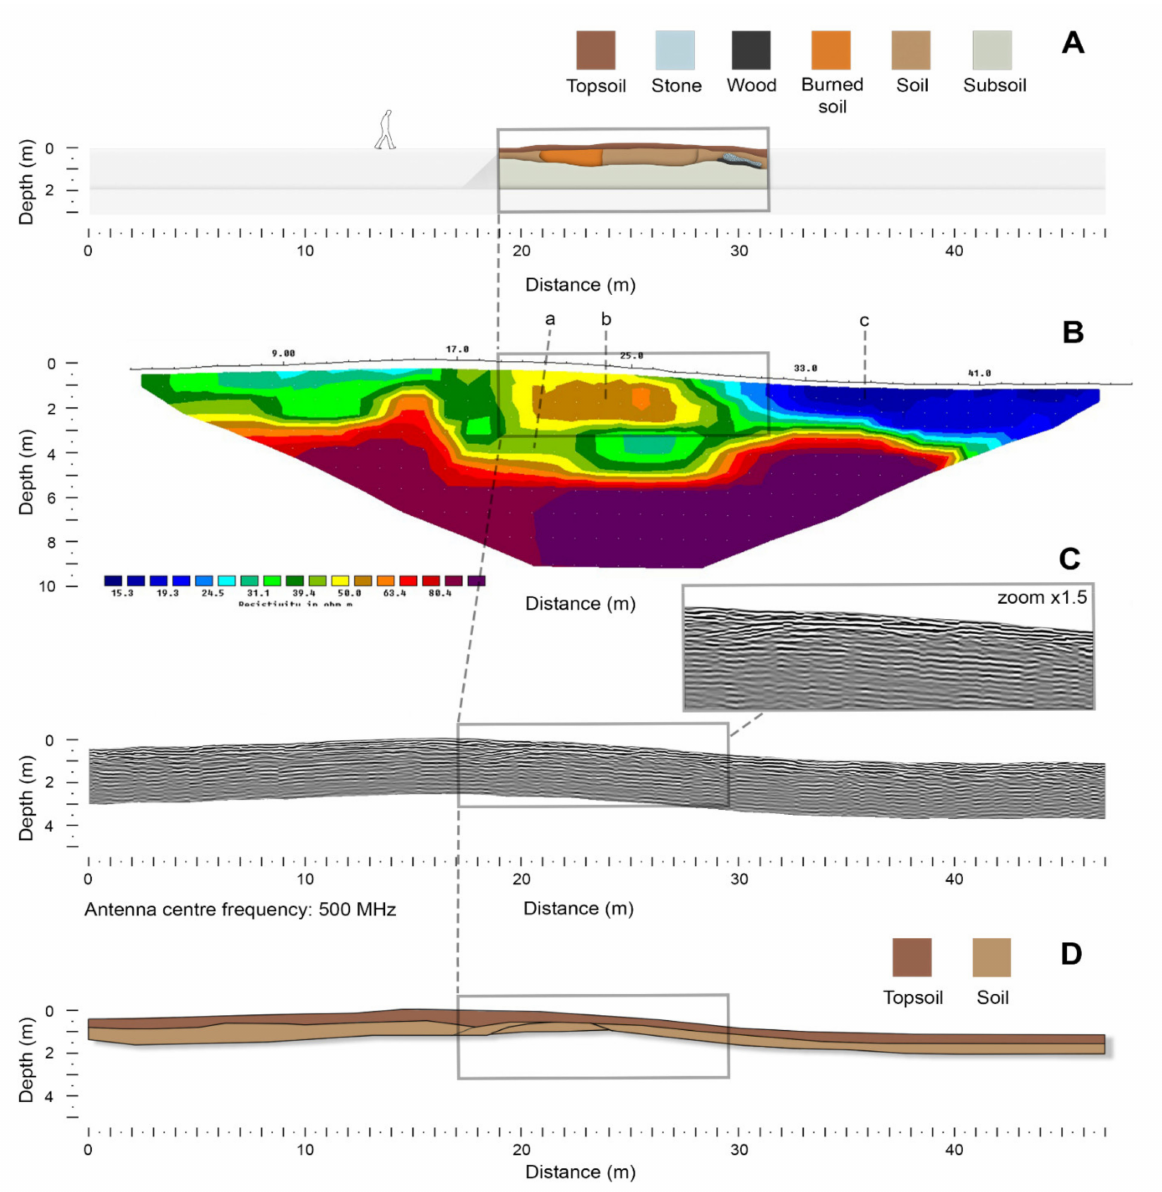
Figure 9. Majcichov. ( A ): Profile of the hillfort’s fortification based on the results of archaeological excavation ([12], Figure 7). ( B ): Electrical resistivity tomography model in Schlumberger configu- ration. ( C ): GPR vertical time/depth radarogram from an antenna with 500 MHz centre frequency. ( D ): Interpretation of the GPR